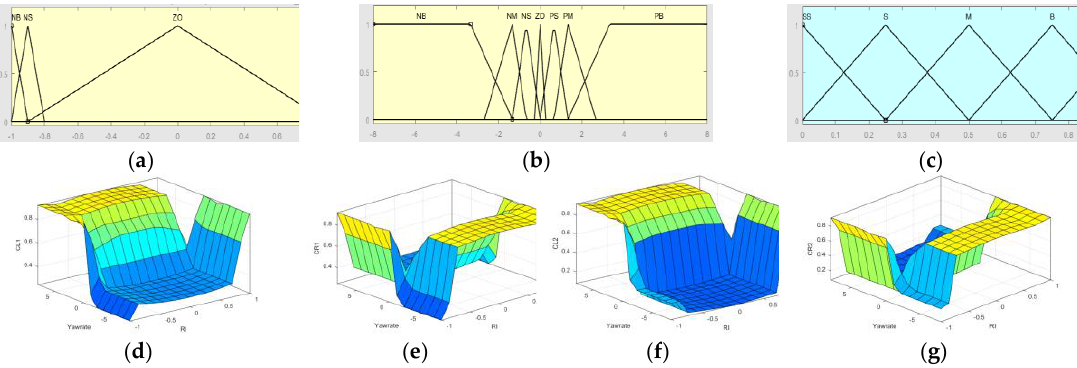
Figure 8. Multi-objective fuzzy continuous damping control model. ( a ), ( b ), and ( c ) are diagrams of the membership functions of the inputs RI and yaw rate and the output damping reference coefficient, respectively. ( d ), ( e ), ( f ), and ( g ) are the diagrams of the rule surface of each wheel (CL1/CR1/CL2/CR2: damping reference coefficient of front left/front right/rear left/rear right wheel, respectively).